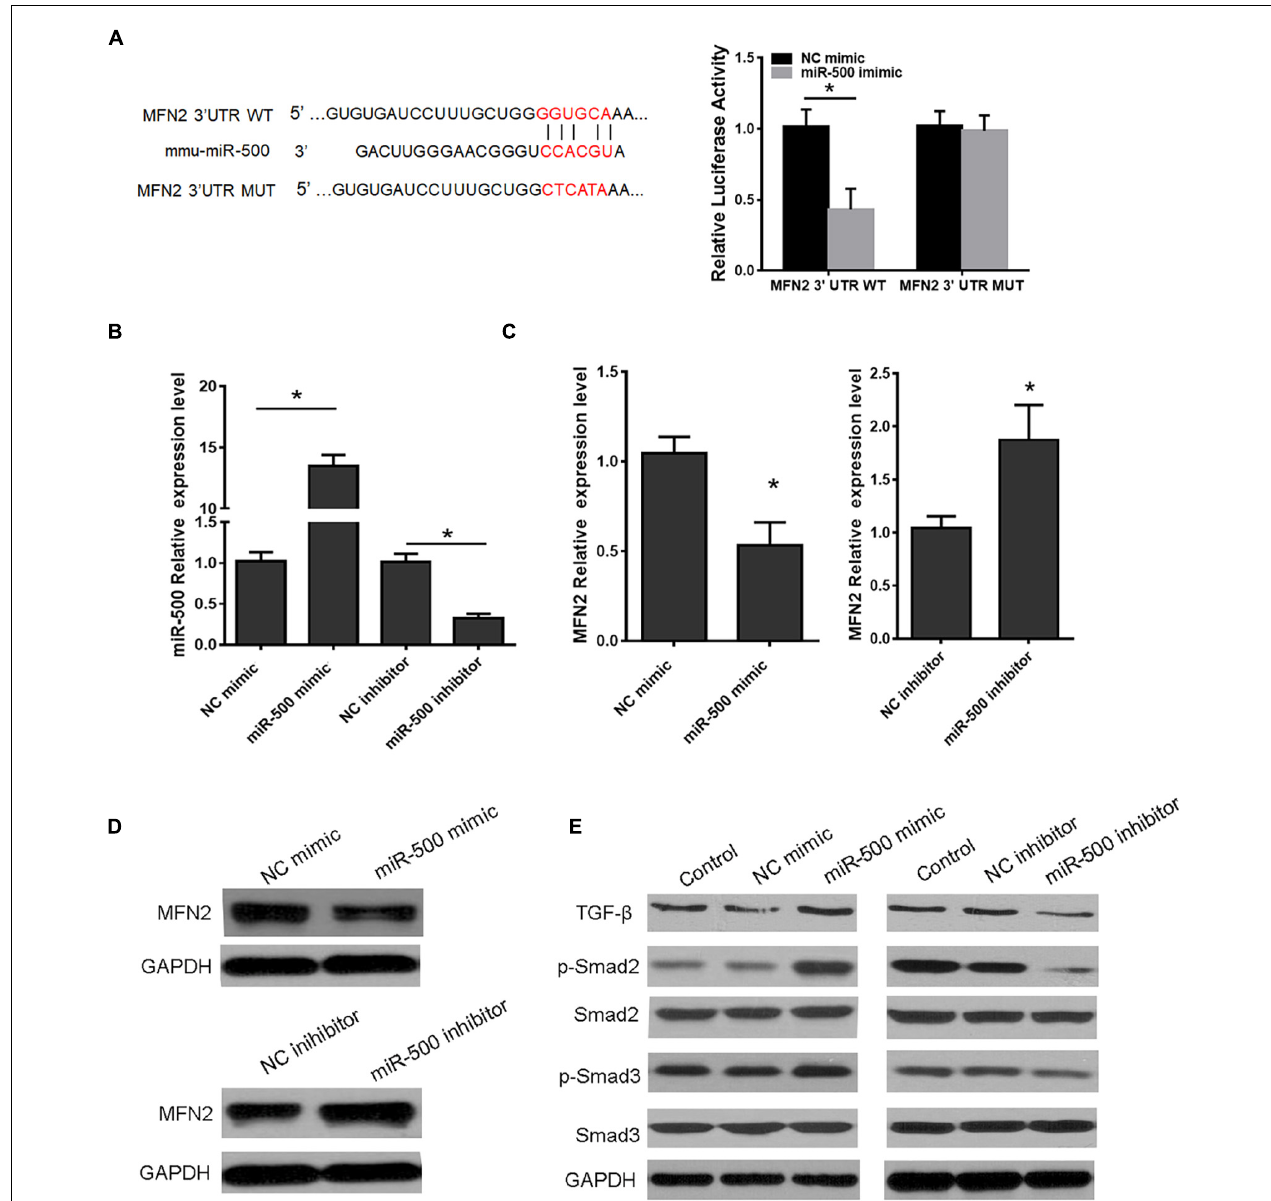
FIGURE 5 | MFN2 is a target of miR-500. (A) Schema showing the binding sites of MFN2 3 (cid:48) UTR with miR-500 (left) and luciferase reporter assays of HEK293 cells with transfection of pMIR-REPORT-WT/MUT MFN2 along with miR-500 mimic or NC mimic as indicated (right). (B) The expression level of miR-500 was detected in HSCs transfected with miR-500 mimic or inhibitor and relative controls. (C) The mRNA expression of MFN2 in HSCs transfected with miR-500 mimic or inhibitor were assessed by qRT-PCR. (D) The protein expression of MFN2 in HSCs with miR-500 overexpression or inhibition were determined by western blot. GAPDH was used as loading control. (E) The protein levels of TGF– β , p–Smad2/Smad2, and p–Smad3/Smad3, in HSCs with miR-500 overexpression or inhibition were assessed by western blot. * P <